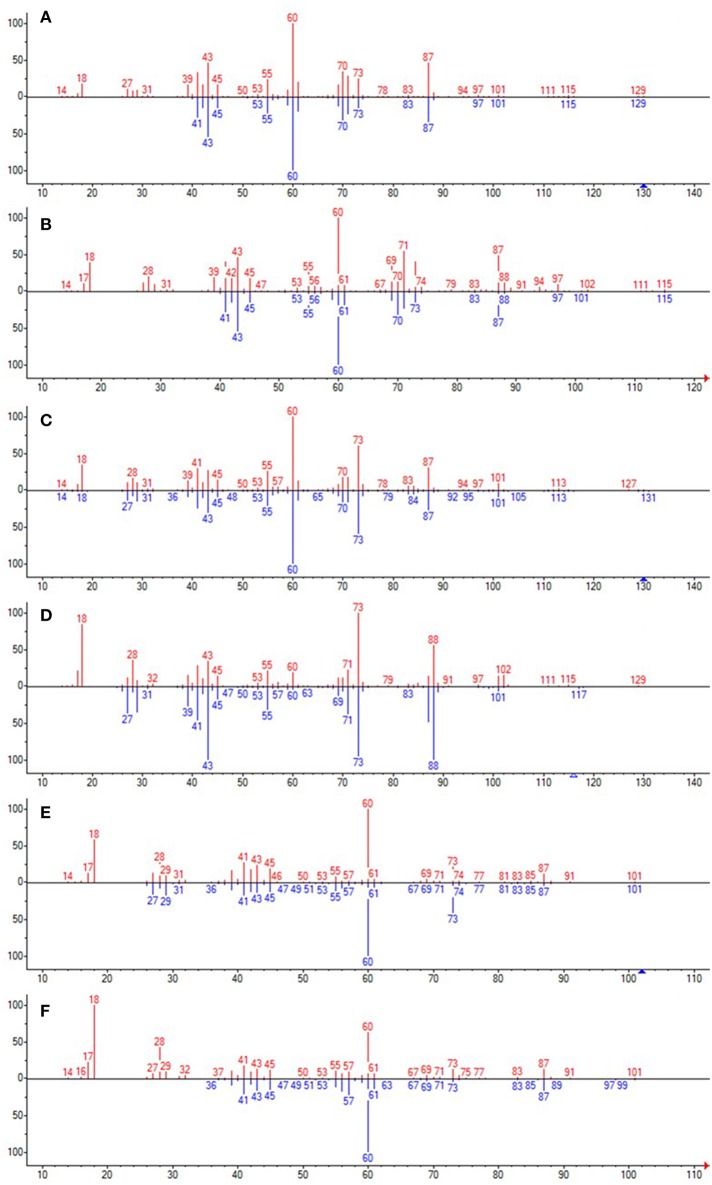
The unknown mass spectrum from GC-MS analysis (in red) associated with the library spectrum (in blue) for the following compounds: 3-methylhexanoic acid (both stereoisomers, A,B), heptanoic acid (C), 2-ethylbutanoic acid (D), pentanoic acid (E), 3-methylpentanoic acid (F).